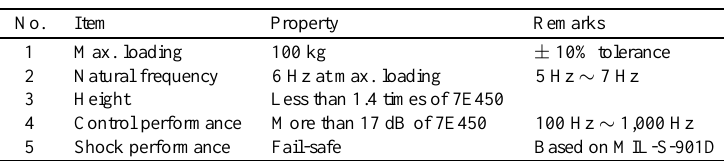
Table 1 Design specification of the hybrid mount